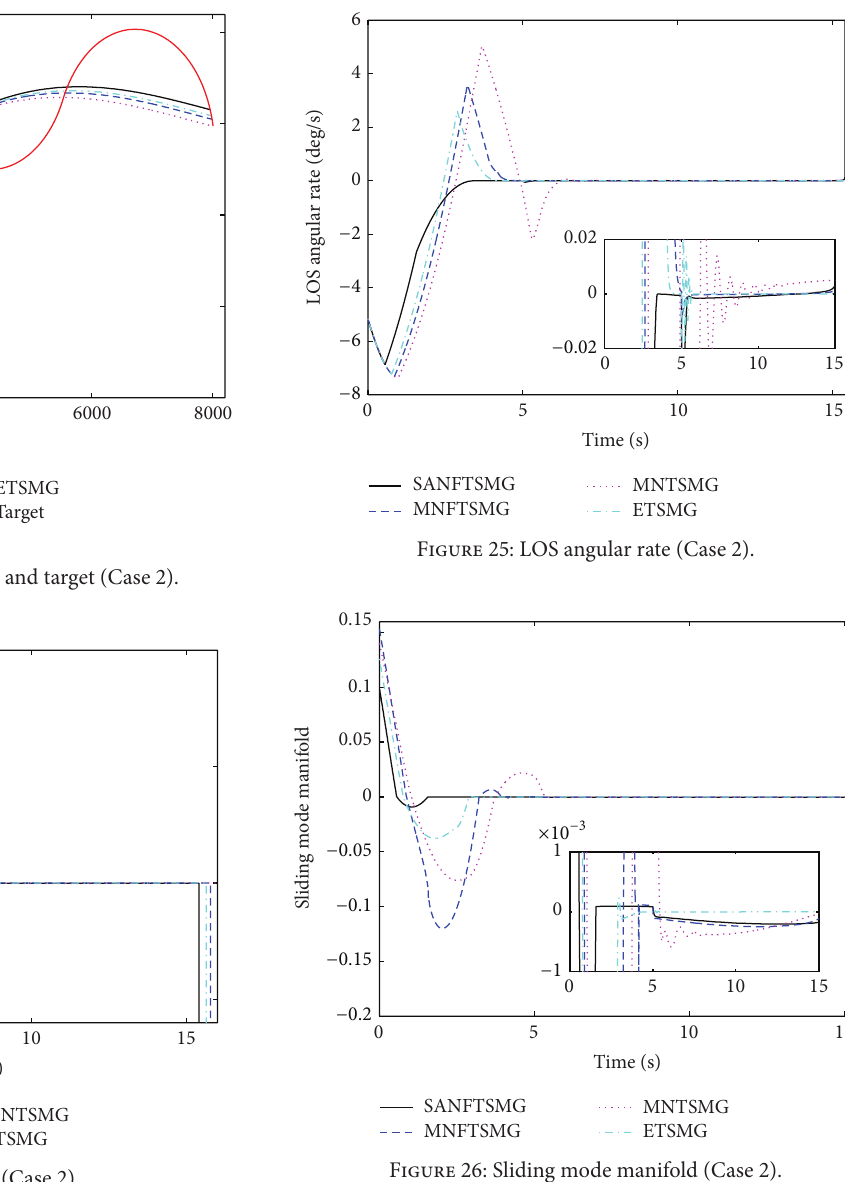
Figure 24: LOS angle (Case 2).